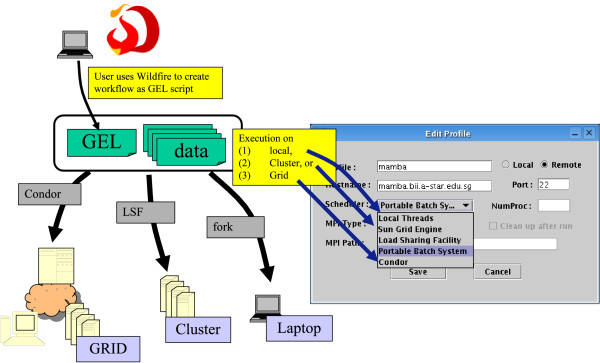
Relationship between Wildfire and GEL. Wildfire is an interactive application which allows users to construct workflows using a drawing analogy. Wildfire executes the workflow by exporting it as a GEL script which is executed using a suitable GEL interpretor. There are GEL interpretors for execution on (i) the Grid, using Condor, (ii) a cluster, using LSF, PBS or SGE, and (iii) the same machine, which could be a laptop, desktop or multi-processor server.